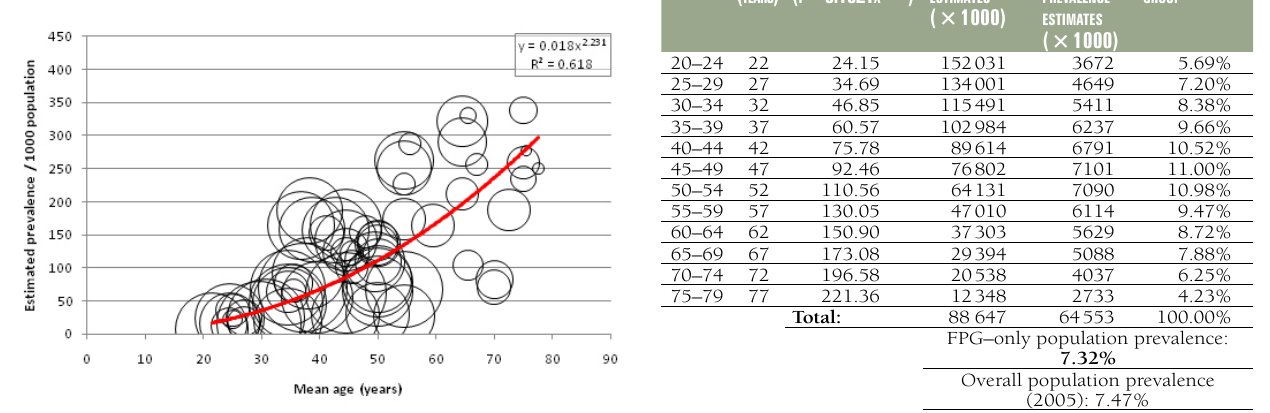
Figure 15. Relationship between crude prevalence of type 2 diabetes and age in Southern Asia based on the studies using FPG+OGTT in their case definition. FPG – fasting plasma glucose, OGTT – oral glucose tolerance test.